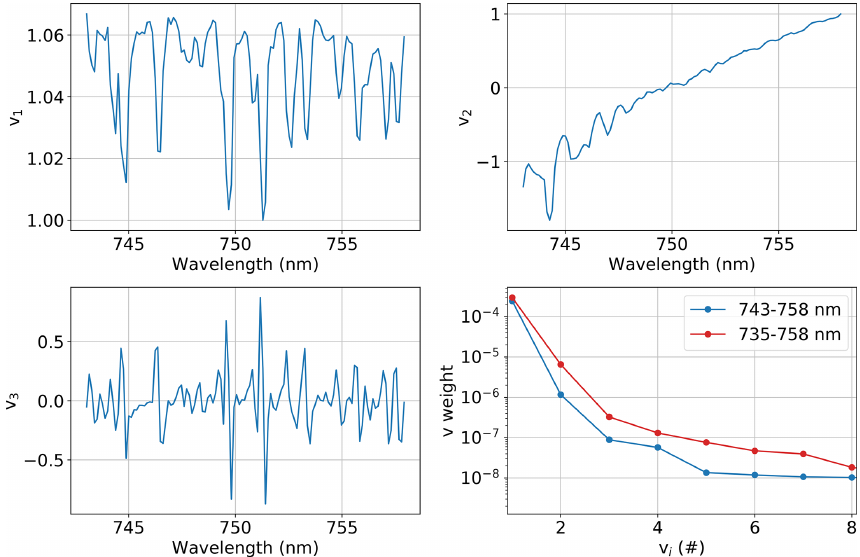
Figure 2. First three singular vectors ( v i ) and weights of the first eight v i for the 743–758 fitting window from the singular vector decom- position of a training set consisting of TROPOMI spectra over non-vegetated areas. The weights of the first eight v i are also shown for the 735–758nm fitting window.